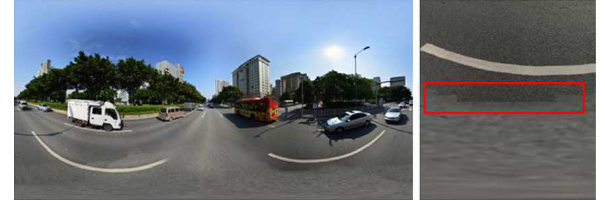
Figure 7. An illustration of obvious artifacts in a completed panorama by just back-projecting the completed image region in the ground perspective plane. overlaps. It can be achieved by solving Eq. (10) through the linear least square